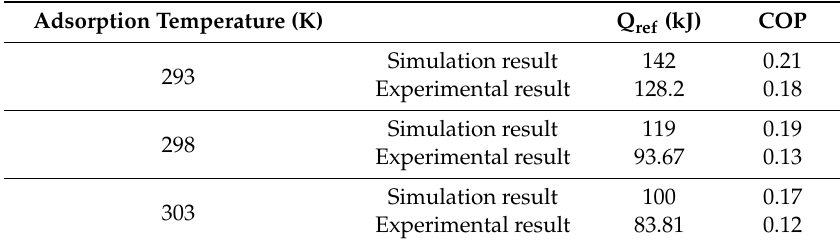
Table 3. Experimental results and simulation results at different adsorption temperatures. Adsorption Temperature